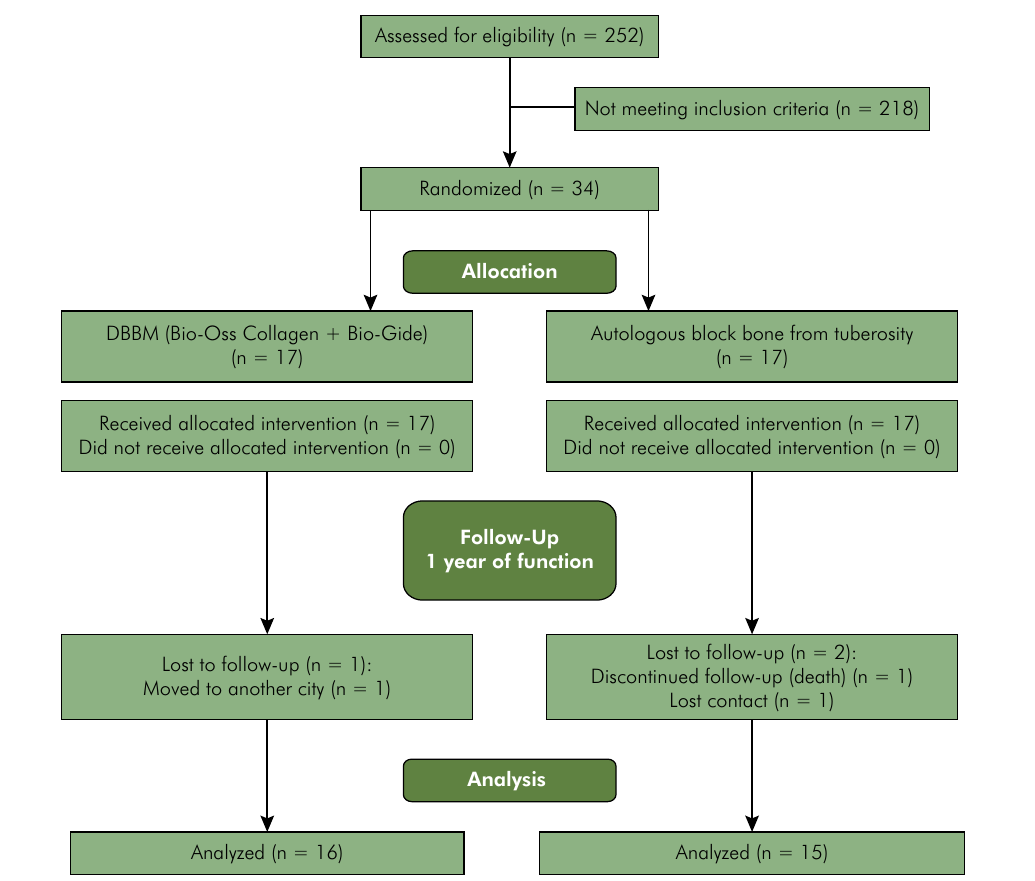
Figure 1. CONSORT flow diagram of study